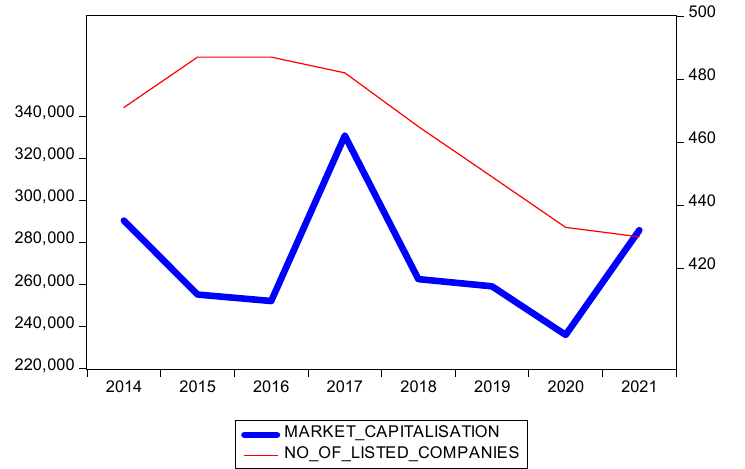
Figure 1. The evolution of the number of listed stocks and the capitalization of the stock market in Poland. Note: Performed by the authors based on the data from the Polish stock market (www.gpw.pl, accessed on 14 June 2022).